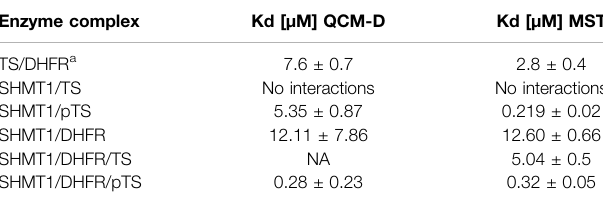
TABLE 1 | QCM-D and MST analyses of protein complex formation. Enzyme